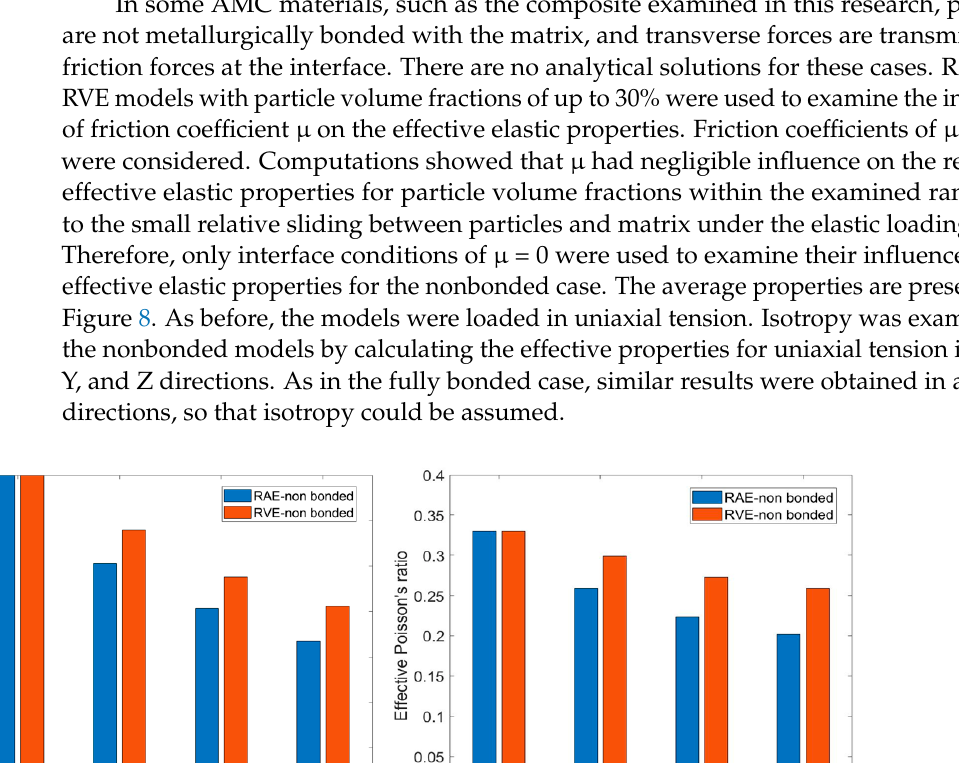
Figure 7. Comparison between 2D and 3D numerical results, and analytical results of effective elastic modulus ( a ) and Poisson’s ratio ( b ) for different particle volume fraction values.